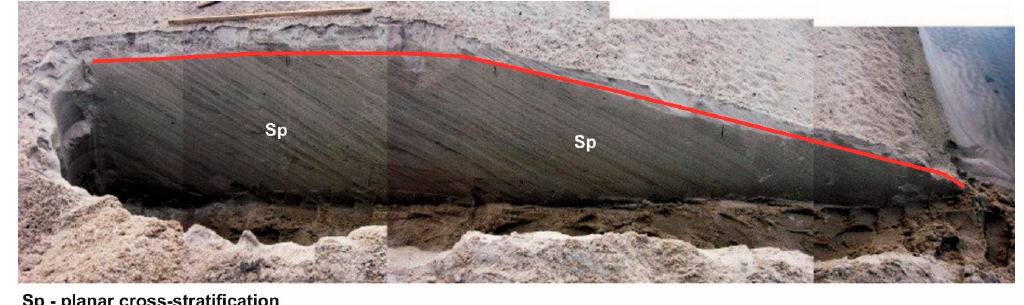
Figure 10. Sedimentary structures in the channel bar head—2 November 2012.